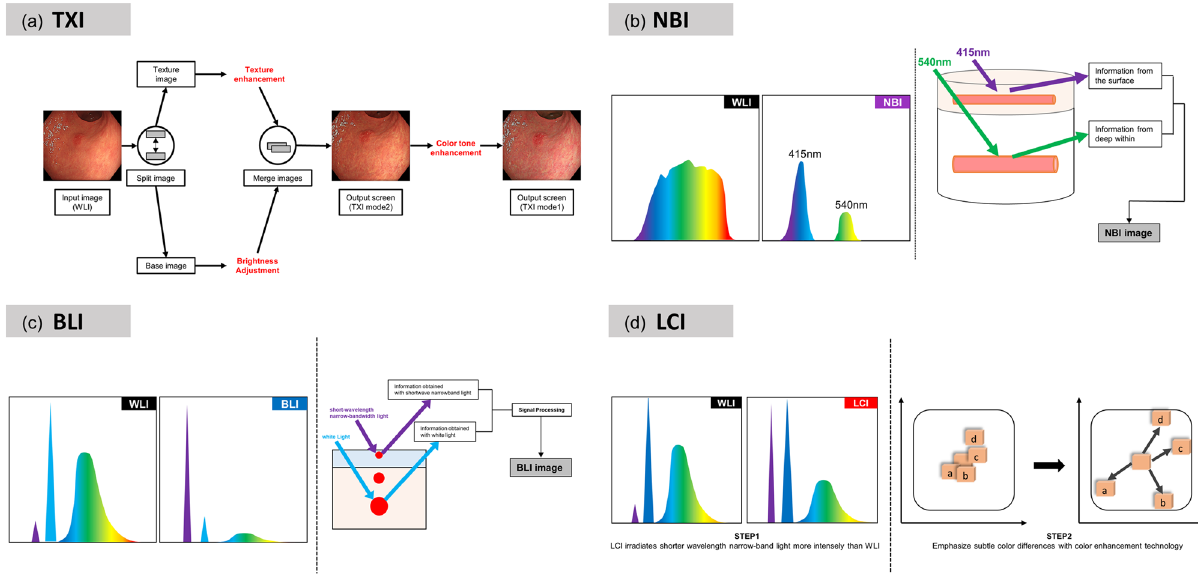
Figure 1. Overview and characteristics of images obtained using TXI and comparison with those of images obtained using other modalities: ( a ) TXI: In the first process of the TXI output, the image obtained from WLI is divided into a base image and a texture image. Then, texture enhancement is applied to the texture image and brightness adjustment is applied to the base image. These two images are combined to produce a TXI mode 2 image. Then, a TXI mode 1 image can be obtained by color enhancement of the TXI mode 2 image. On the other hand, NBI ( b ), BLI ( c ), and LCI ( d ) all obtain information by strongly irradiating a narrow band of light, which is thought to be more suitable for observing information on the mucosal surface and blood vessels. LCI is similar to TXI in that it uses color enhancement technology to enhance the visibility of lesions, while TXI differs from LCI in that it does not use more narrow-band light and adds texture